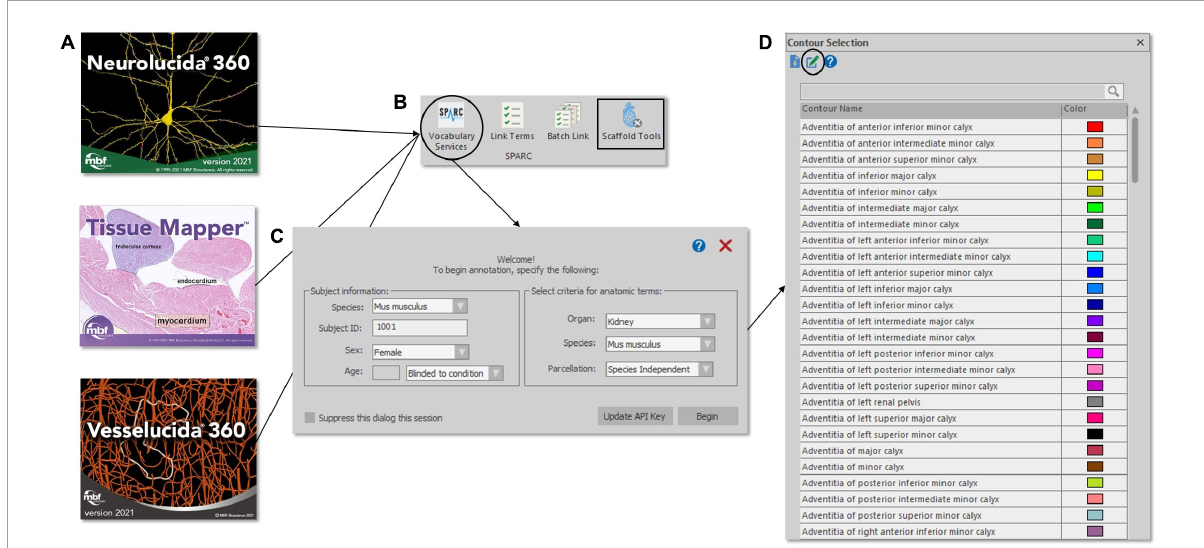
FIGURE4 Accessing the SPARC Vocabulary through an API in the MBF Bioscience software suite (A) . The Vocabulary Services tool ( B , circle) provides users with a subset of SPARC Terms (D) – specified by organ, species, and parcelation (C) – that can be applied to anatomical annotations. An option to request new terms ( D , circle) launches the SAWG portal dashboard. SPARC Terms are also available through Scaffold Tools ( B , square), where segmentation data and organ scaffolds are displayed side-by-side to preview concordant fiducial SPARC terms for subsequent scaffold